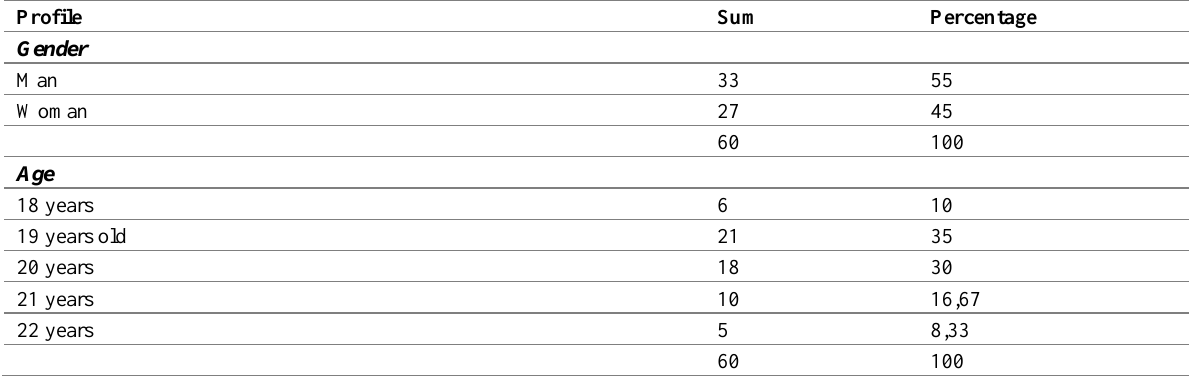
Table 1: Participant Demographic Profile